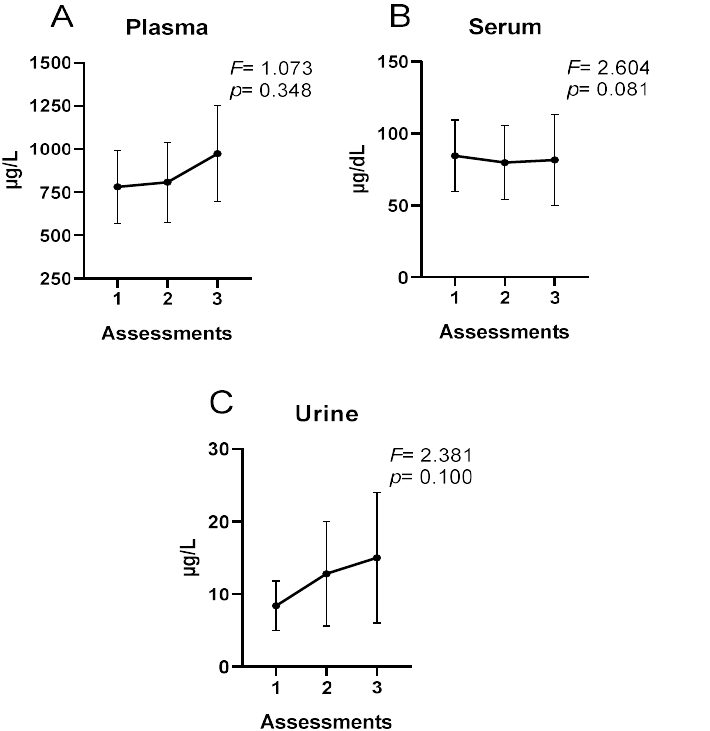
Figure 1. Extracellular Fe concentrations: ( A ) plasma concentrations; ( B ) serum concentrations; ( C ) urinary concentrations. Figure 2 shows the erythrocyte and platelet Fe concentrations during the sports sea- son.